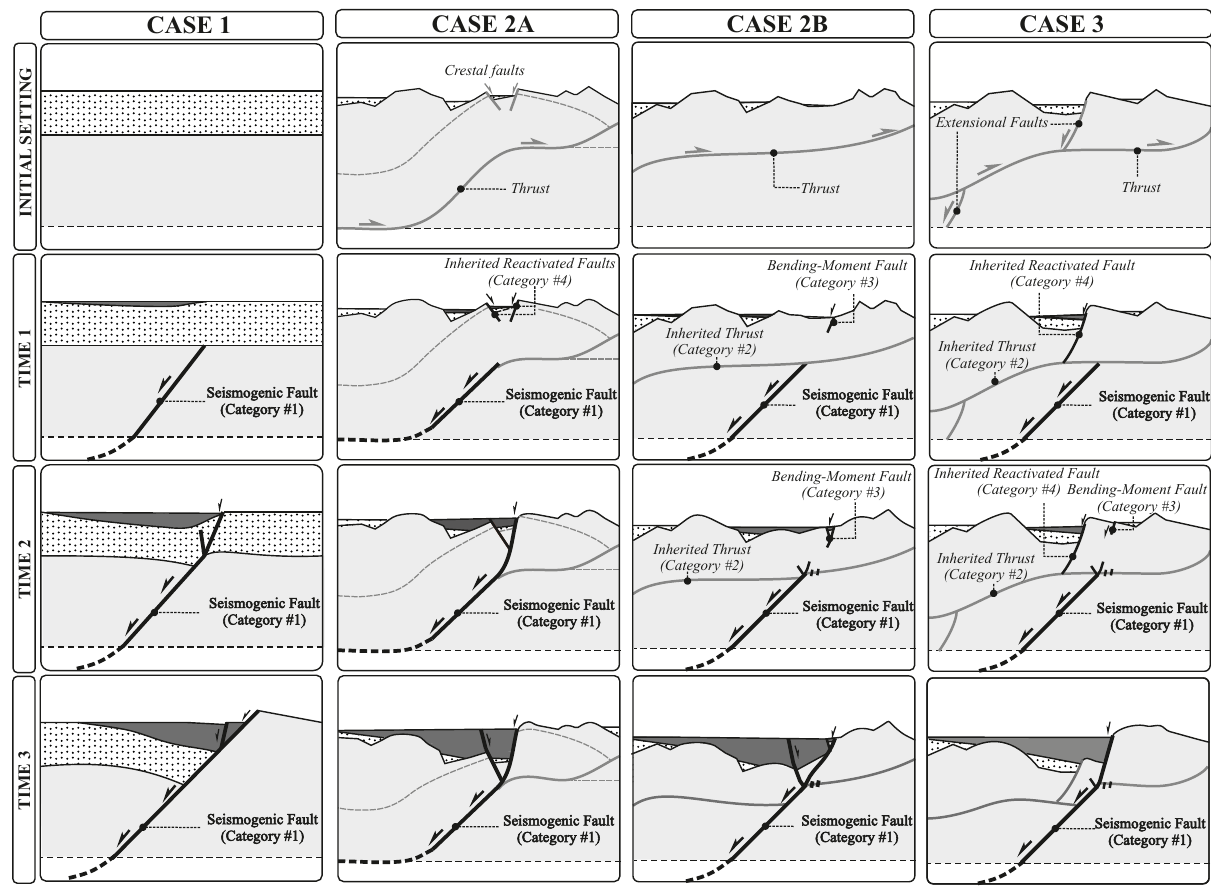
Figure 13. Images showing an inferred sequential development of a seismogenic master fault (Category #1) and its ancillary structures (Category #2, Category #3, and Category #4) in four different tectonic scenarios. Gray and black lines represent inherited structures and active faults, respectively. The panels labeled TIME 1, TIME 2 and TIME 3 show successive steps of fault evolution. In CASE 1 the initial setting does not exhibit significant inherited mechanical discontinuities; the seismogenic fault easily reaches the surface. CASE 2 (A and B) comprises two scenarios of geodynamic change, i.e., from compression to extension. In CASE 2A the seismogenic master fault (Category #1) is an inherited thrust ramp (Category #2) reactivated since the early stages of extension (TIME 1); crestal faults that developed along the extrados of the thrust-related fold may be reactivated (Category #4), mimicking a surface-breaking master fault. In CASE 2B an inherited thrust plays a segmentation role (Category #2) and slows down the upward propagation of the master fault, causing extreme bending of the surface rather than faulting and promoting the creation of bending-moment faults (Category #3). CASE 3 is the most complex, as it shows a scenario of both positive and negative inversion. The seismogenic fault interacts with an inherited thrust at shallower crustal levels, generating bending-moment faults (Category #3) and remobilizing an inherited extensional fault plane that simulates a fully primary surface